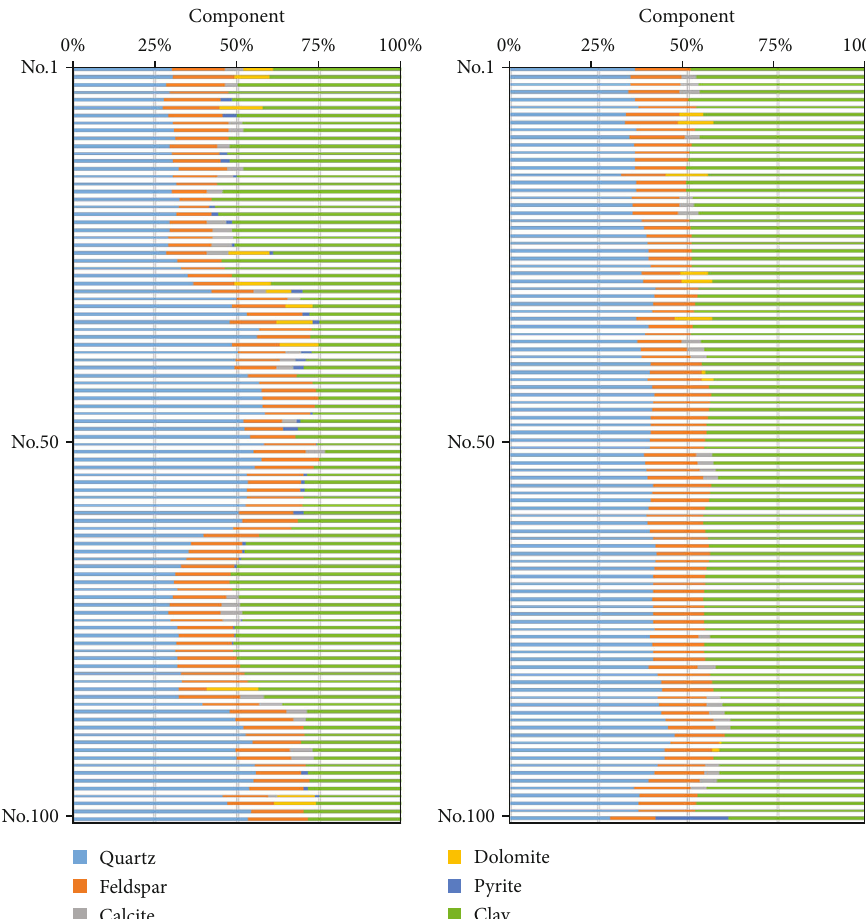
Figure 5: Distribution of mineralogy composition along the measured region (red blocks in Figure 1) of the (a) silty laminated sample and (b) the massive argillaceous shale.